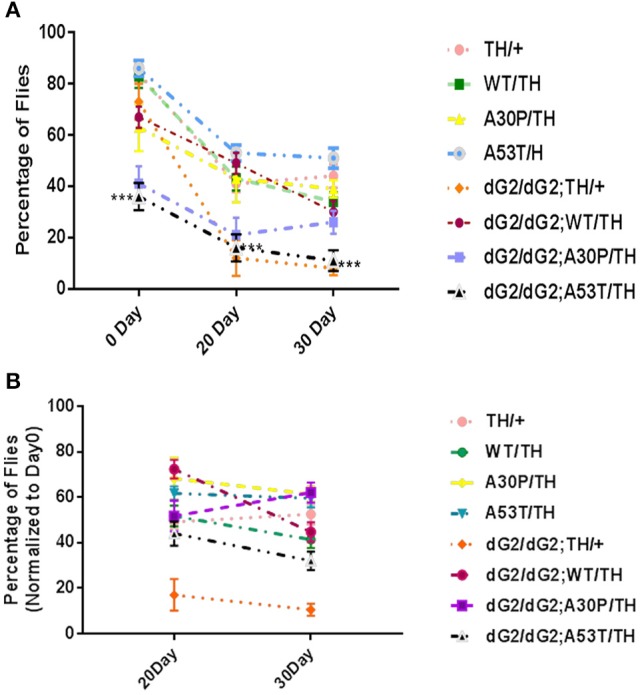
Decreased activity of dG2/dG2 flies in negative geotaxis assay. (A) Negative geotaxis assay revealed a decreased movement in dG2/dG2; A53/TH compared to A53T/TH and dG2/dG2 control flies at Day0. (B) Climbing Index of old flies (20 and 30 day) normalized to 0 day young flies for each genotype showed a significant decline in activity with age in case of control dG2/dG2 flies. The dG2/dG2 A53T flies did not show prominent decline compared to dG2/dG2 control because the movement is severely compromised in these flies even at day 0. Data represents Mean + S. E. M of 3 independent experiments. Multiple comparisons between means were done by one-way ANOVA followed by Bonferroni correction. Comparison was done between TH/+ vs. dG2/dG2;TH/+, dG2/dG2 vs. dG2/dG2;WT/TH, dG2/dG2; A30P/TH and dG2/dG2;A53T and WT/TH vs. dG2/dG2;WT/TH and A30P vs. dG2/dG2;A30P/TH and A53T vs. dG2/dG2;A53T/TH). *** represents p < 0.0001.